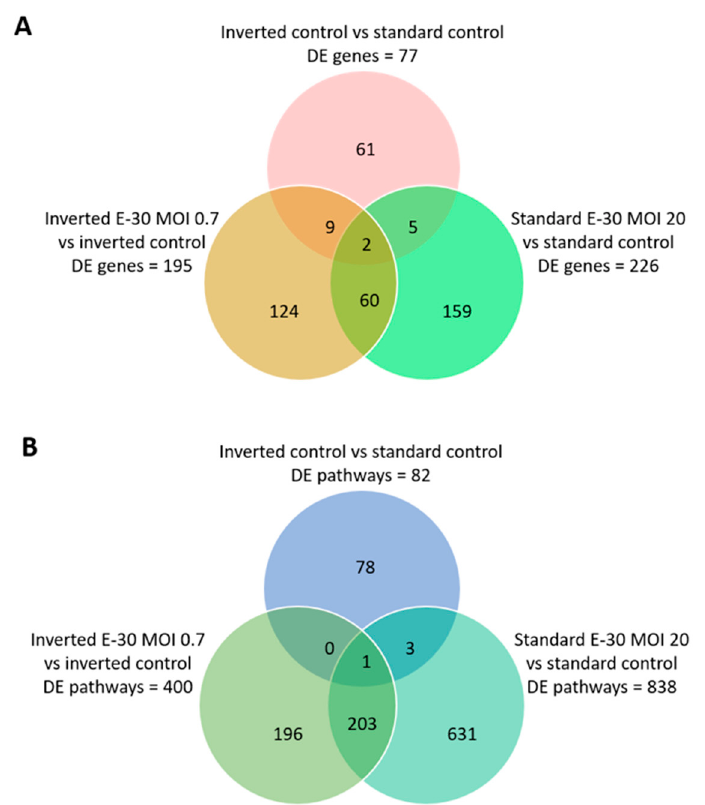
Figure 5. Di ff erentially expressed genes and pathways following polar E-30 infection of HIBCPP cells. Venn diagram representing di ff erentially expressed genes ( A ) and pathways ( B ) following infection of HIBCPP cells with E-30 from the apical (standard E-30 MOI 20) or basolateral side (inverted E-30 MOI 0.7), versus the respective uninfected control conditions (inverted control and standard control). Comparisons resulted in a p -value and log2-fold change (log2FC) for every gene for the 3 experiments. Genes with p < 0.05, and a | log2FC | > 1 were considered as di ff erentially expressed ( n =